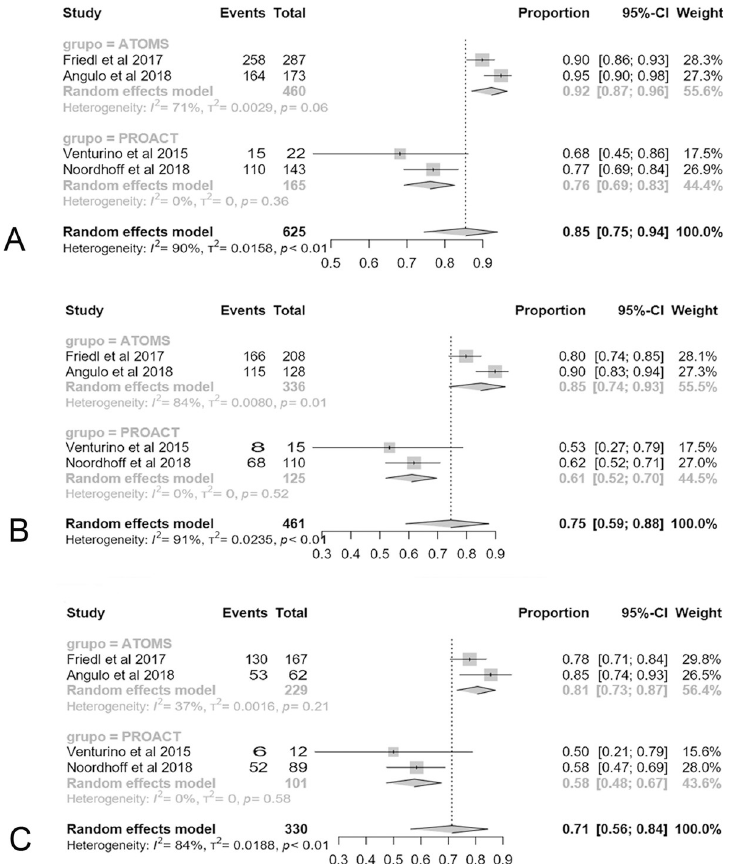
Fig 10. Forest plot of studies analyzed with durability of the devices at 12-months (A), 24-months (B) and 36-months (C).